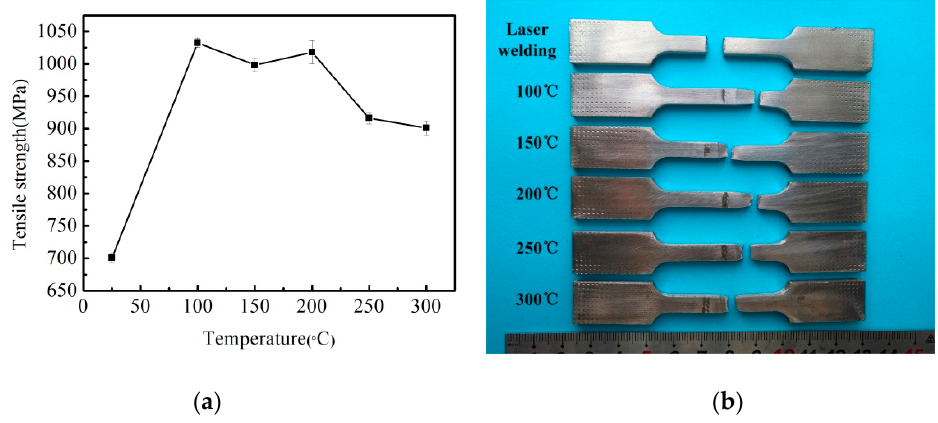
Figure 12. Effect of preheating on tensile properties of 42CrMo/38MnVS6 laser welded joint: ( a ) effect Figure 12. E ff ect of preheating on tensile properties of 42CrMo / 38MnVS6 laser welded joint: ( a ) e ff ect of preheating temperature on tensile strength; ( b ) effect of preheating temperature on fracture of preheating temperature on tensile strength; ( b ) e ff ect of preheating temperature on fracture location. Metals 2019 , 9 , x FOR PEER REVIEW location.